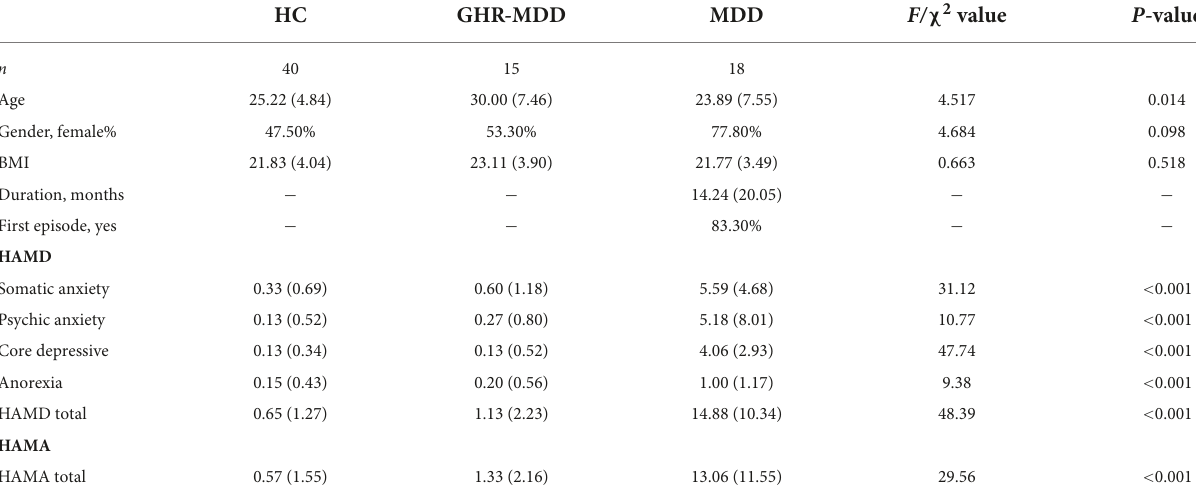
TABLE 1 Demographic and clinical characteristics of HC, HR-MDD, and drug-naïve